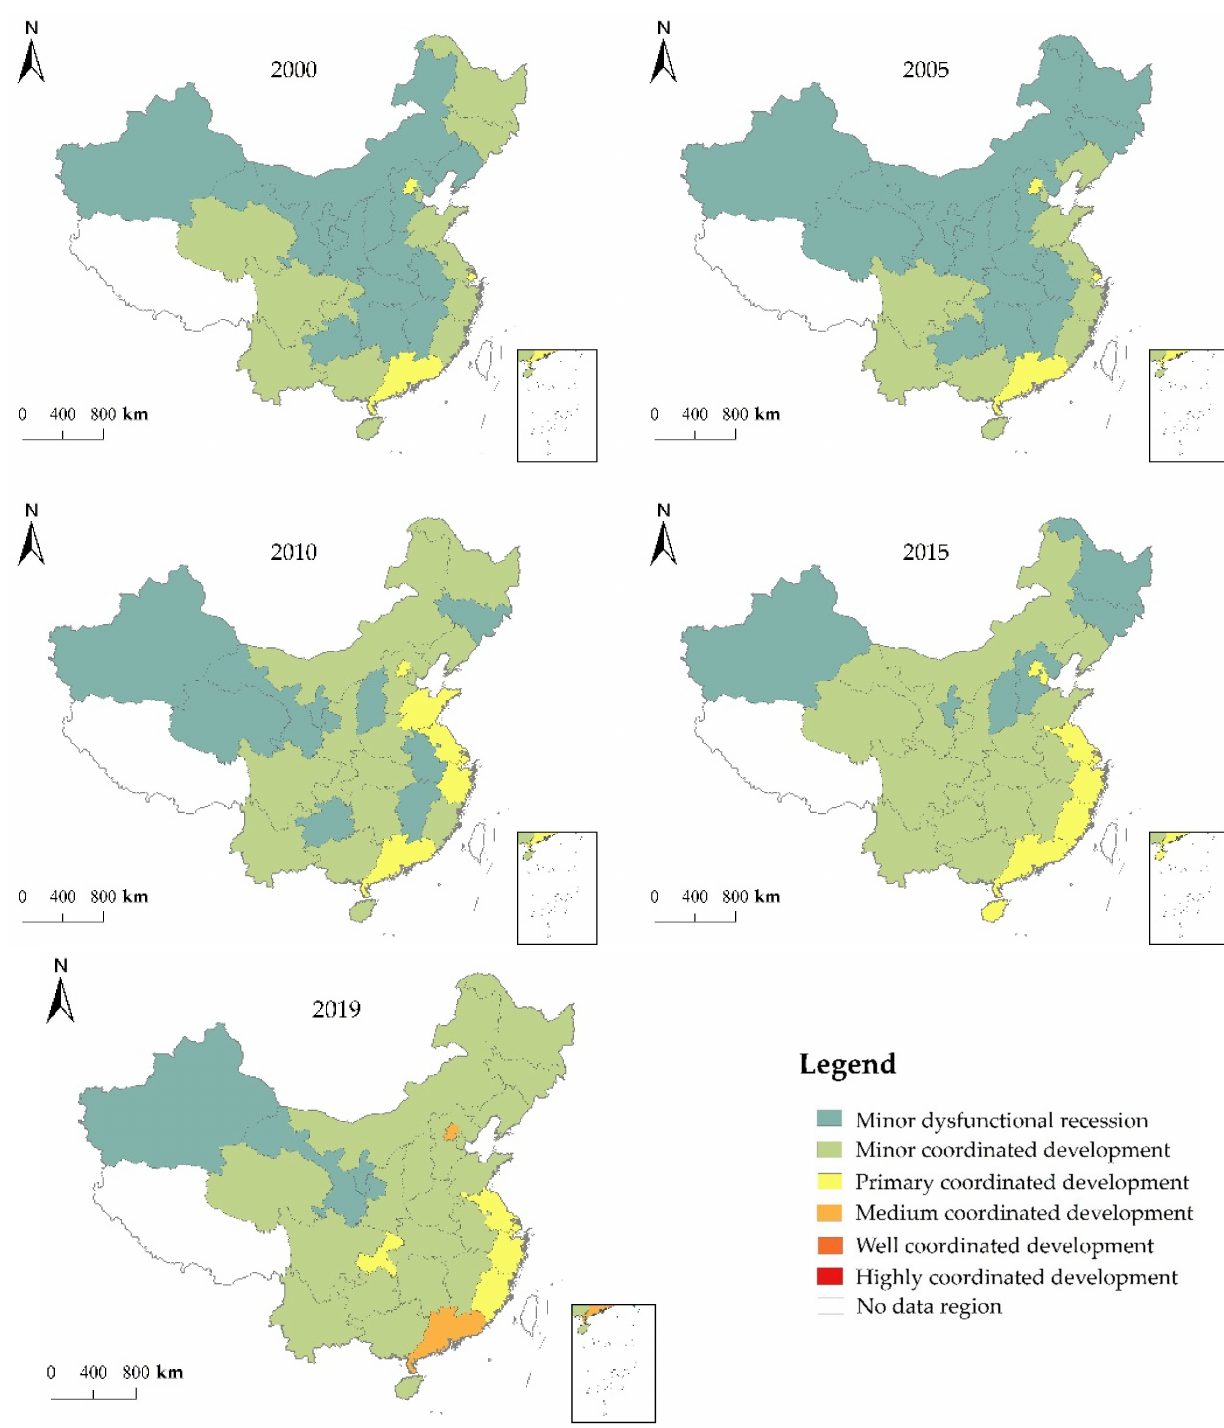
Figure 1. Coordinated development of the 3E system in